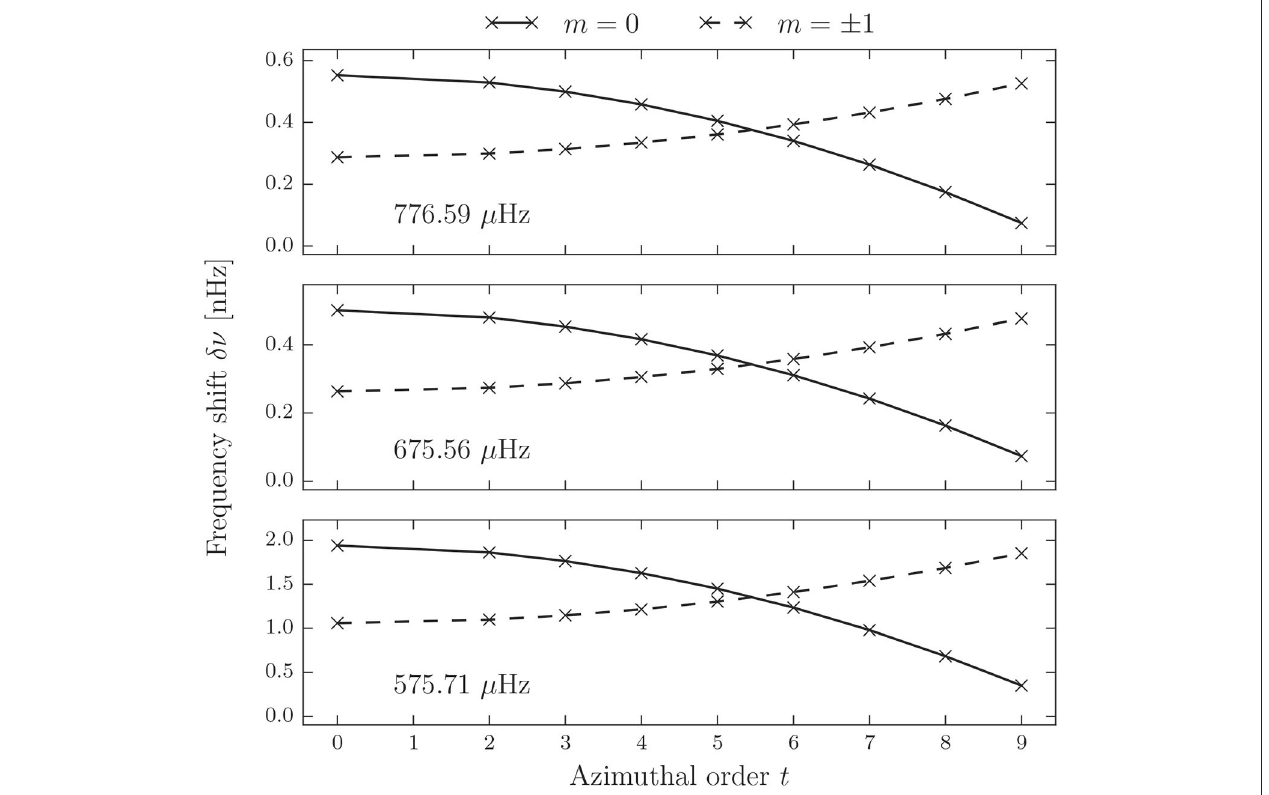
t 9 and 0,2, ... ,9. Shifts of the m = | | =